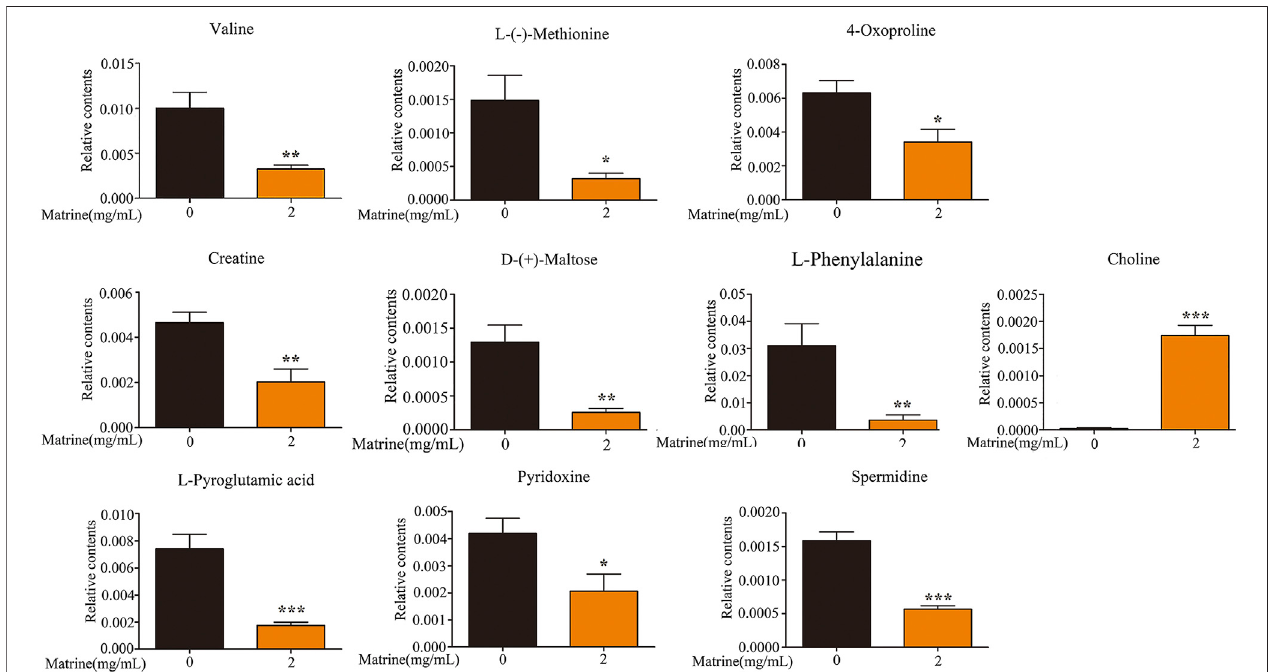
FIGURE 3 | Levels of differential metabolites in SMMC-7721 cells after treatment of matrine. * p < 0.05, ** p < 0.01, *** p < 0.001 versus control group.